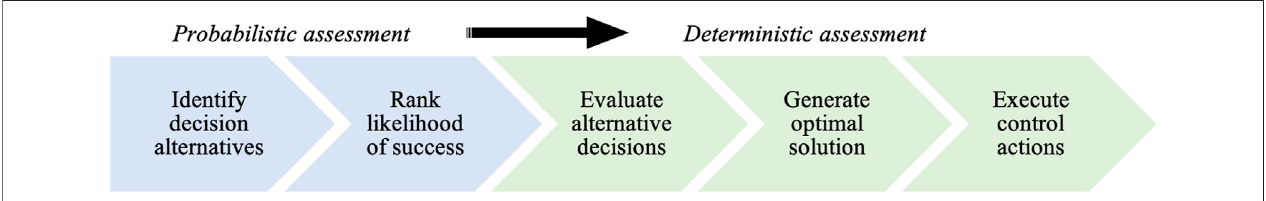
FIGURE 5 | Core elements within the generalized framework for autonomous